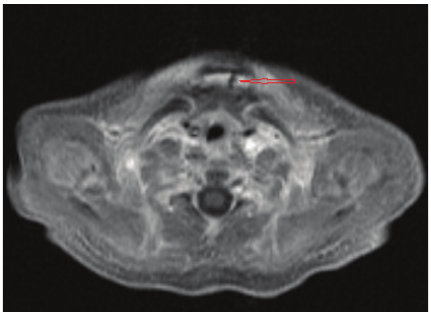
Figure 3: Postgadolinium fat saturated T1 axial MR image of the neck shows midline low T1 signal blind ending cleft in the skin/subcutaneous fat (red open arrow).